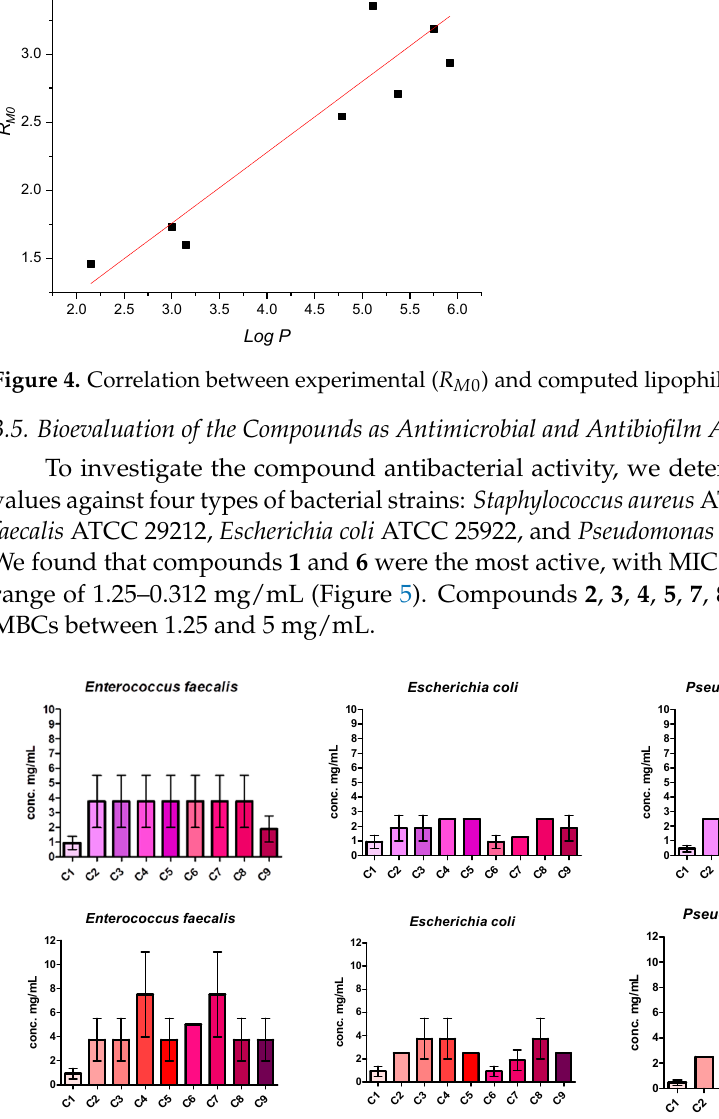
Figure 5. Top: MIC values obtained for compounds 1–9 for S. aureus , E. faecalis , P. aeruginosa , and E. coli ; bottom: similarly, MBC values.